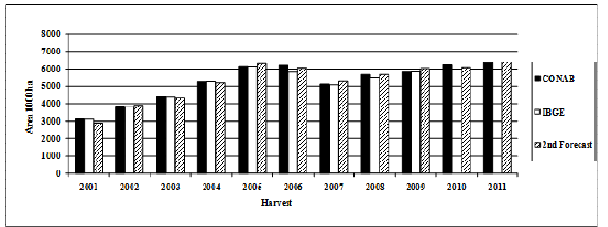
Figure 2. Comparison between MCDA (2 nd forecast), IBGE and CONAB soybean area estimates for Mato Grosso